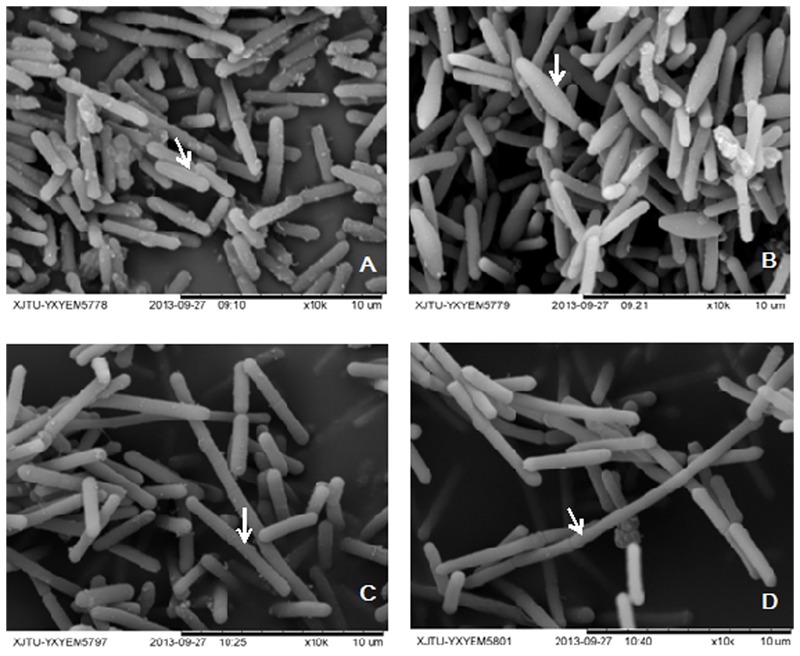
Electron micrograph of Clostridium beijerinckii NCIMB 8052 WT-8052 and DG-8052 cells. WT-8052 cells were taken at 12 h (A) and 24 h (B); DG-8052 cells were taken at 12 h (C) and 24 h (D). WT-8052 cells at 12 h were in rod-shape, and in rod-shape with a rounded end at 24 h, which indicating the developing of pre-endospores; DG-8052 cells were all in non-split and elongated rod-shape both at 12 and 24 h, which were disable to produce solvents and form spores. The typical cells were indicated by white arrows.